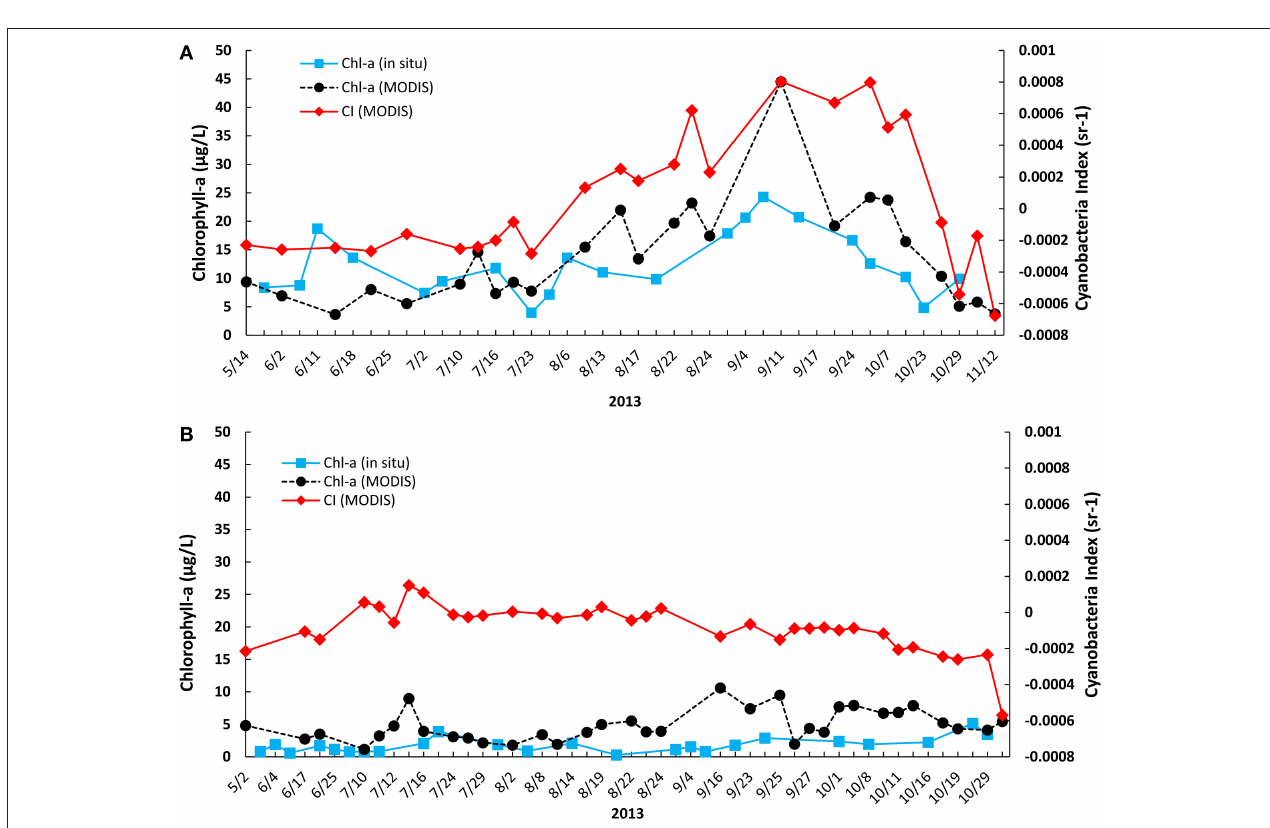
FIGURE 3 | Temporal trends of MODIS-retrieved chlorophyll- a , cyanobacteria index, and in situ measured chlorophyll- a at Toledo and Painesville water plant intake points from May to October in 2013: (A) Toledo; (B) Painesville.